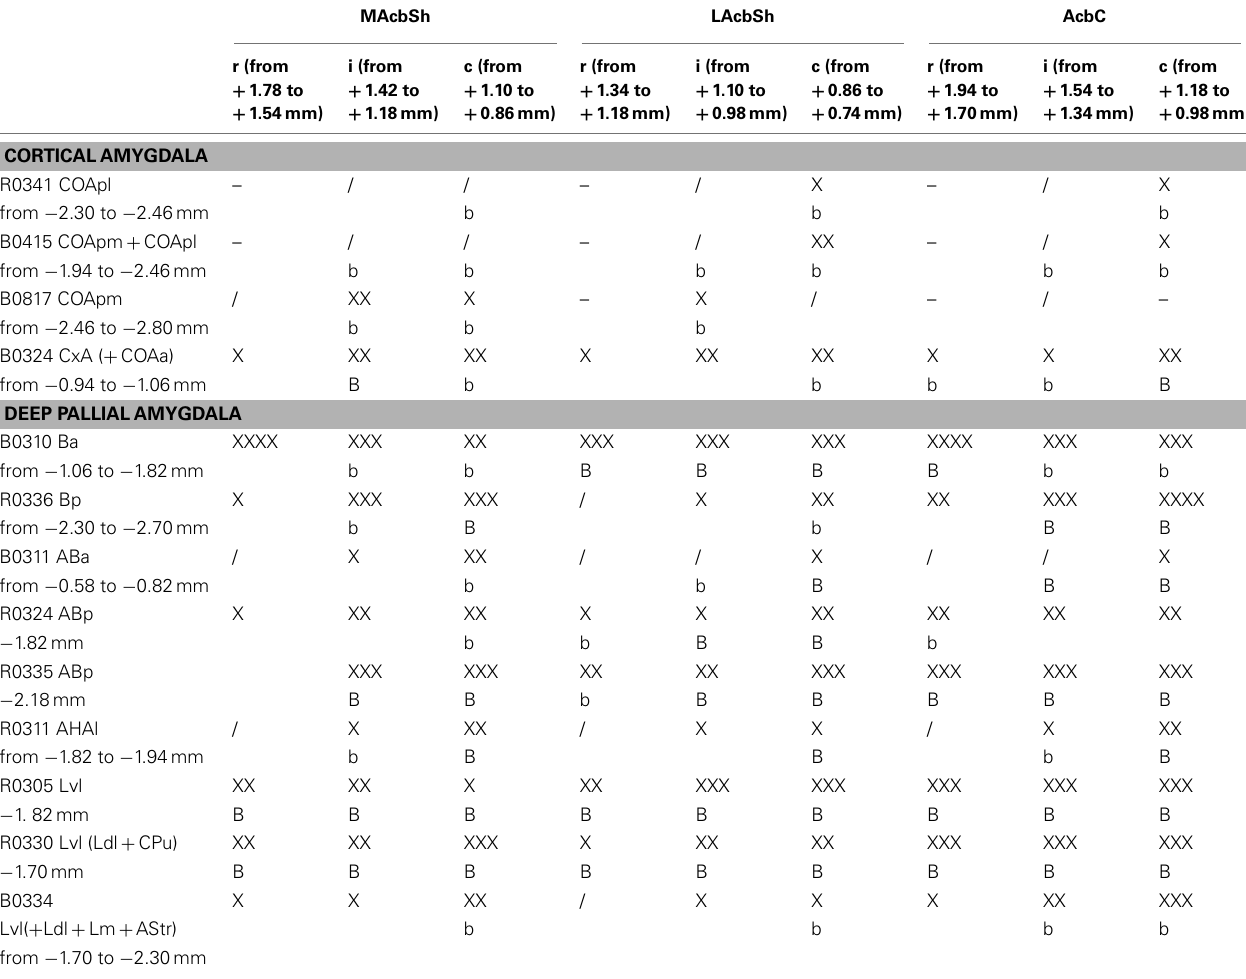
Table 2 | Semiquantitative rating of the density of the anterograde labeling found in three rostro-caudal levels of the nucleus accumbens shell and core (columns) after different injections in the cortical and deep pallial amygdala